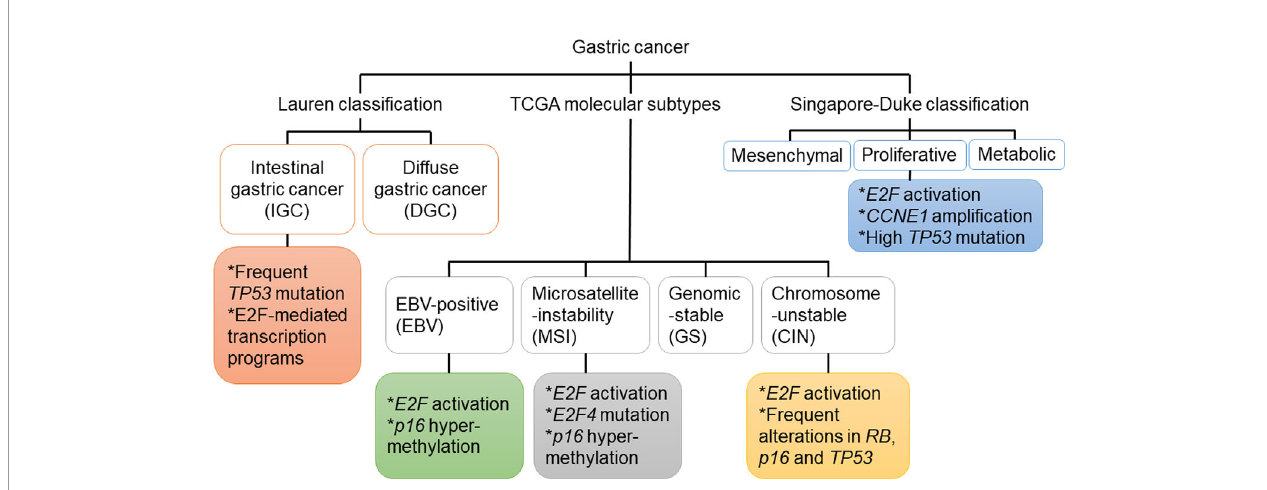
FIGURE 1 | Genetic and epigenetic mutations of genes in key components of the RB-E2F pathway that were identi fi ed in different subtypes of gastric